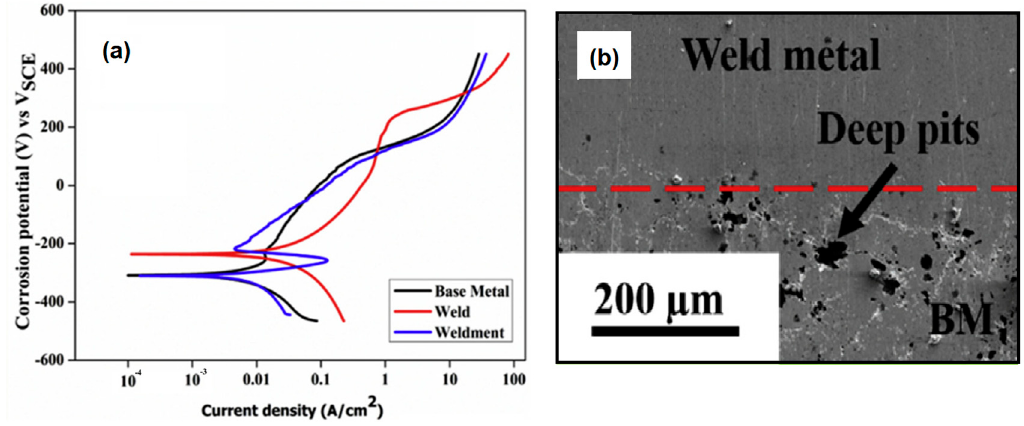
Figure 6. ( a ) Corrosion behavior and ( b ) deep pits near the interface between WZ and BM of Al 0.5 CoCrFeNi HEA. Adapted from [27].